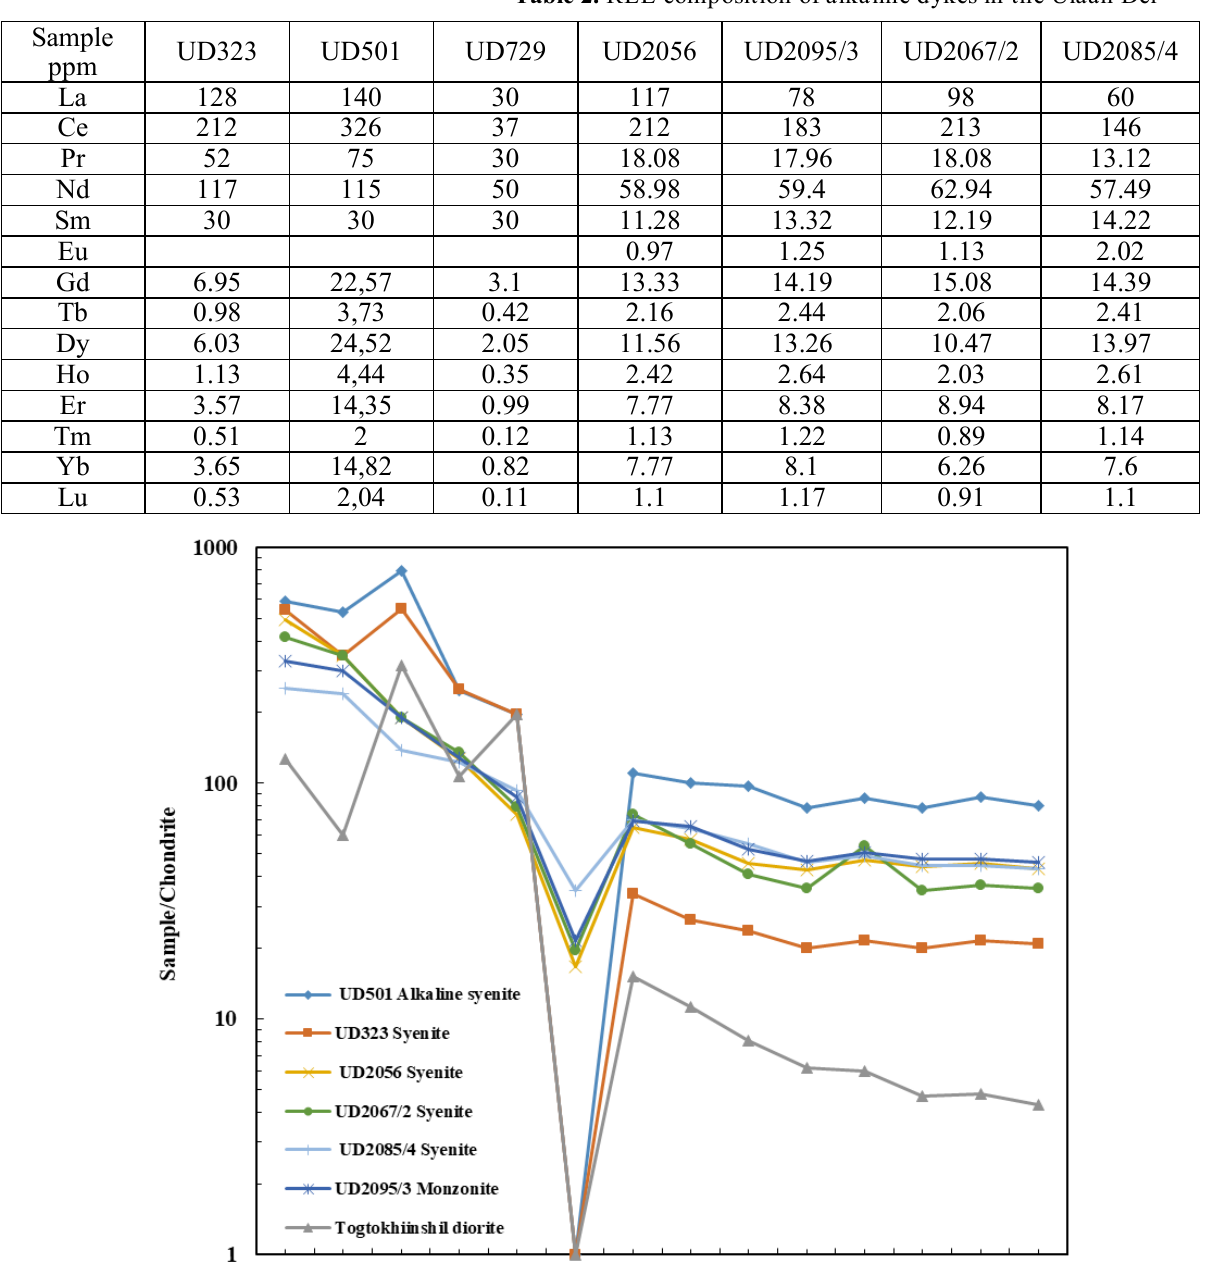
Table 2. REE composition of alkaline dykes in the Ulaan